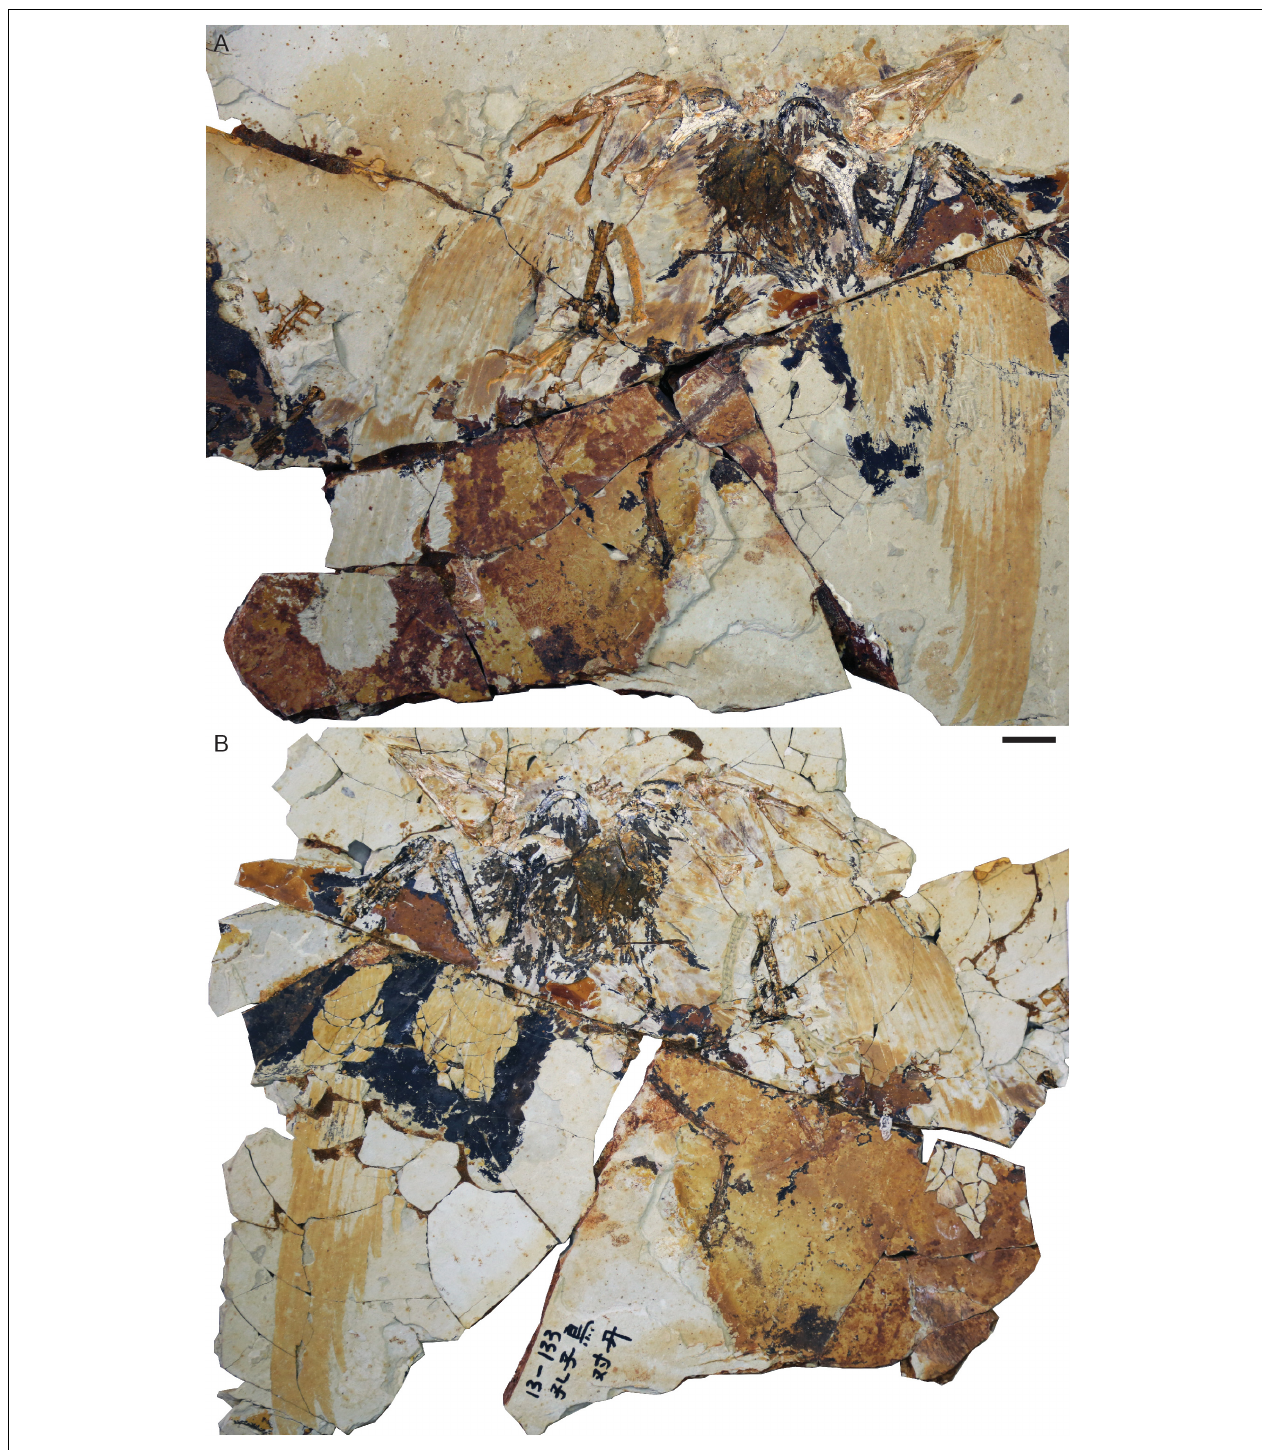
FIGURE 1 | Confuciusornis sp. STM13-133: (A) main slab; (B) counter-slab. Scale bar equals two centimeters.